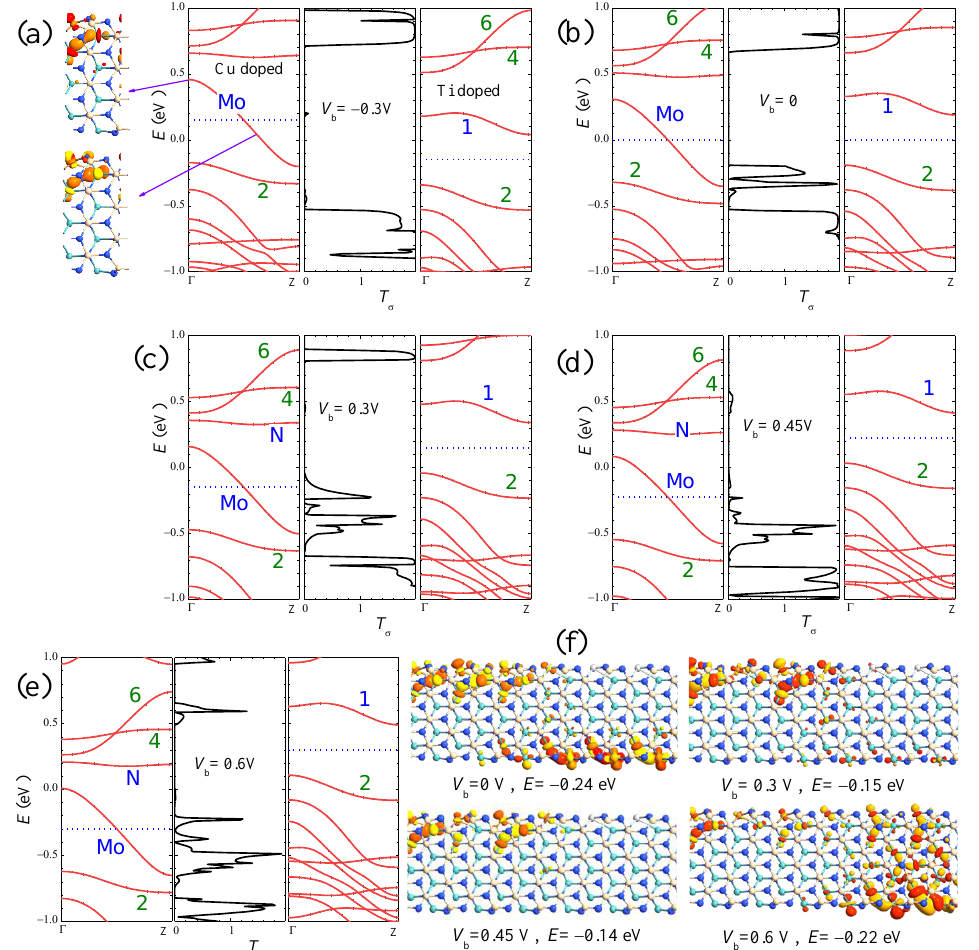
Figure 8. The combination plots of the band structure for left electrode (left panels), the transmission spectra T σ (middle panels), and the band structure for the right electrode (right panels) at the bias of ( a ) −0.3 V, ( b ) 0, ( c ) 0.3 V, ( d ) 0.45 V, ( e ) 0.6 V for the Cu/Ti-aMoSiNNR heterojunction. The transmission eigenstates at some typical values of V b and E are shown in ( f